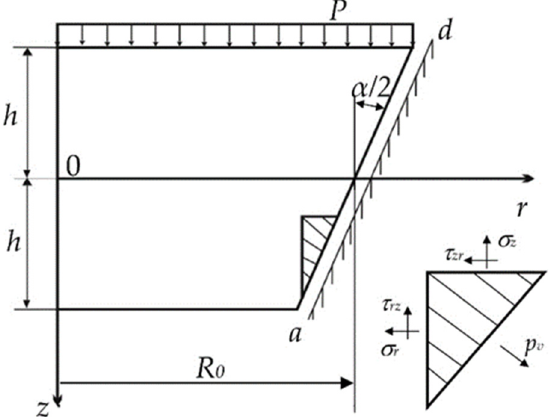
Figure 2. Translucent-element loading diagram: h— half-thickness of the translucent element; R 0 — average radius.